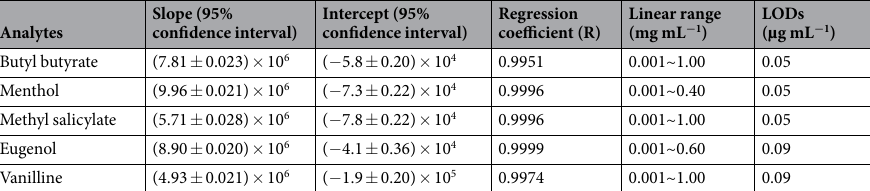
Table 4. Calibration curves of five analytes in ethanol and performance parameters.